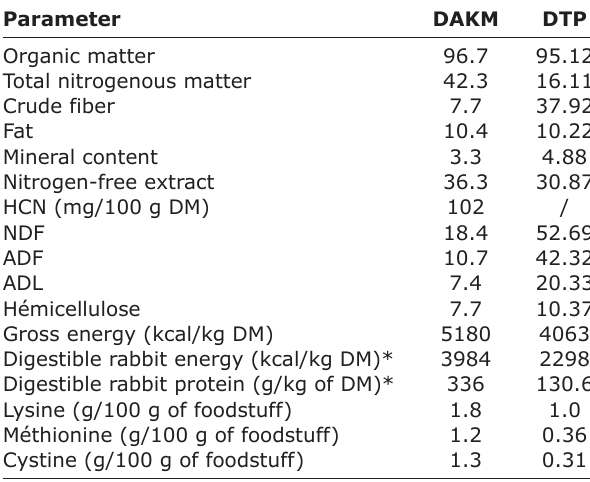
Table-1: Chemical composition of detoxified almond cake (DAKM) and DTP in % DM. Parameter